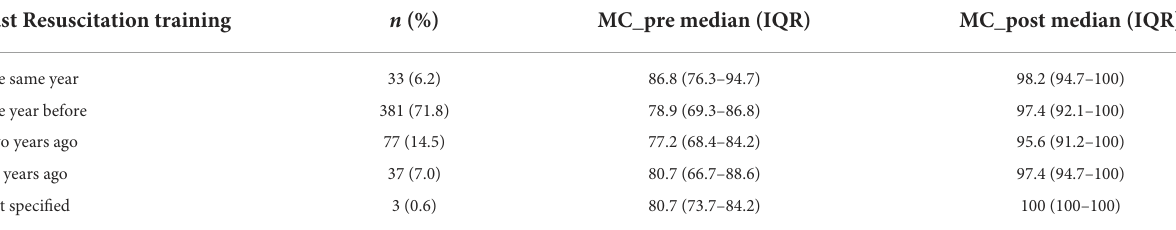
TABLE 4 Last resuscitation training and median percentage of correctly answered multiple-choice test questions of the multiple-choice carried out before the course (MC_pre) and after the course